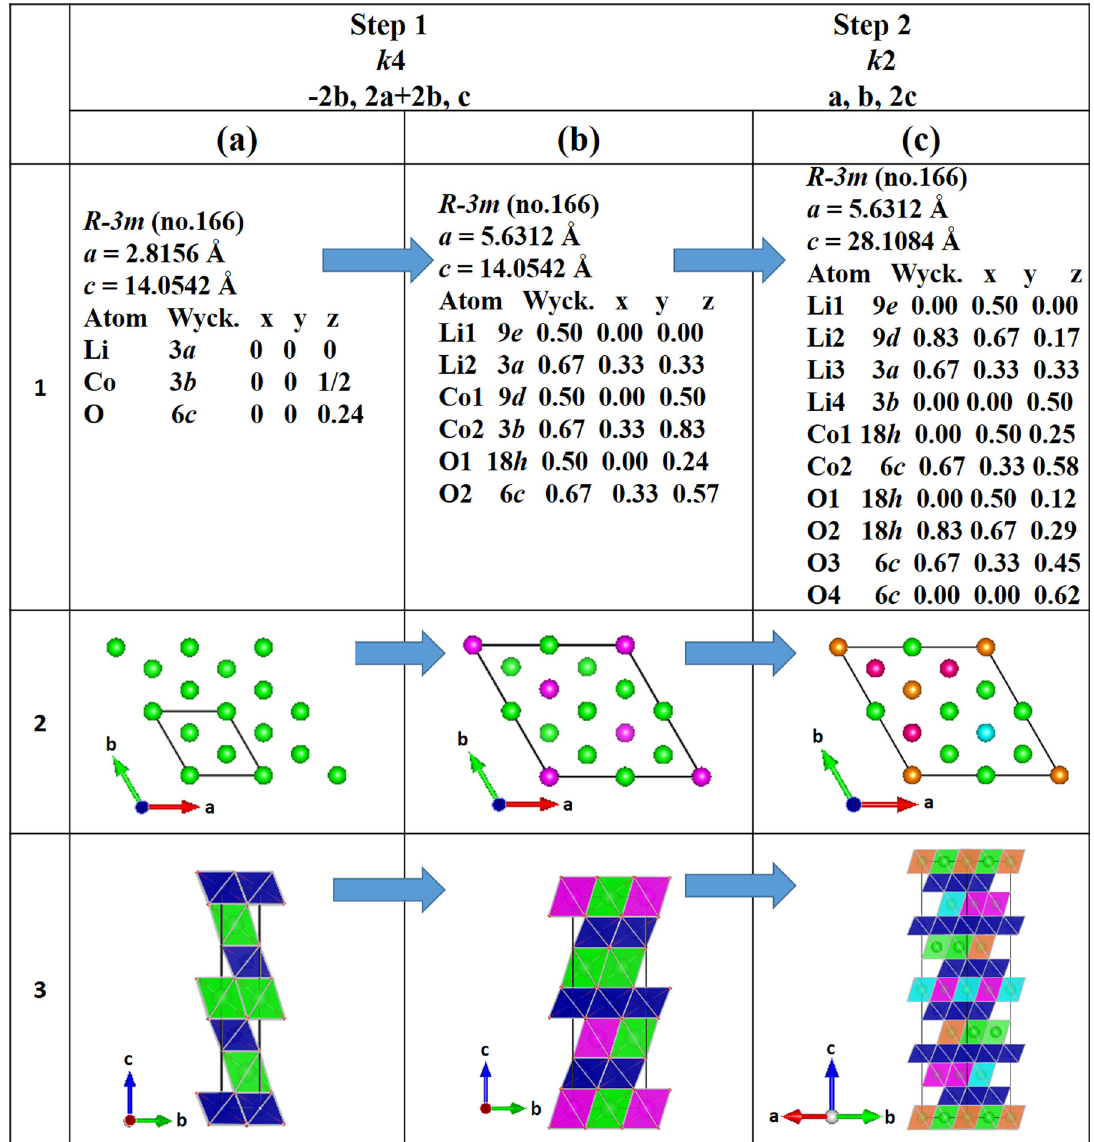
Fig. 2 Phase transitions from LiCoO 2 to Li 0.875 CoO 2 . a LiCoO 2 original structure. b Isomorphic enlargement with an index of 4 in ab plane. c Isomorphic enlargement with an index of 2 along c axis. Li1, Li2, Li3, and Li4 are colored in green, pink, yellow, and cyan,